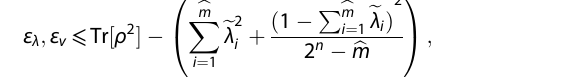
= = Fig. 3 Ansatz diagram. a Layered hardware-ef fi cient ansatz for V ( θ ). A single layer of the ansatz is composed of two-qubit gates B μ ( θ μ ) acting on neighboring qubits. Shown is the case of two layers. b While there are many choices for each block B μ ( θ μ ), in our numerics we employed two different parameterizations. Top: Each gate is composed of a controlled- Z gate preceded and followed by single-qubit rotations about the y -axis R y ð θ Þ ¼ e i θσ y . Bottom: Each gate is composed of a CNOT gate preceded and followed by a single-qubit